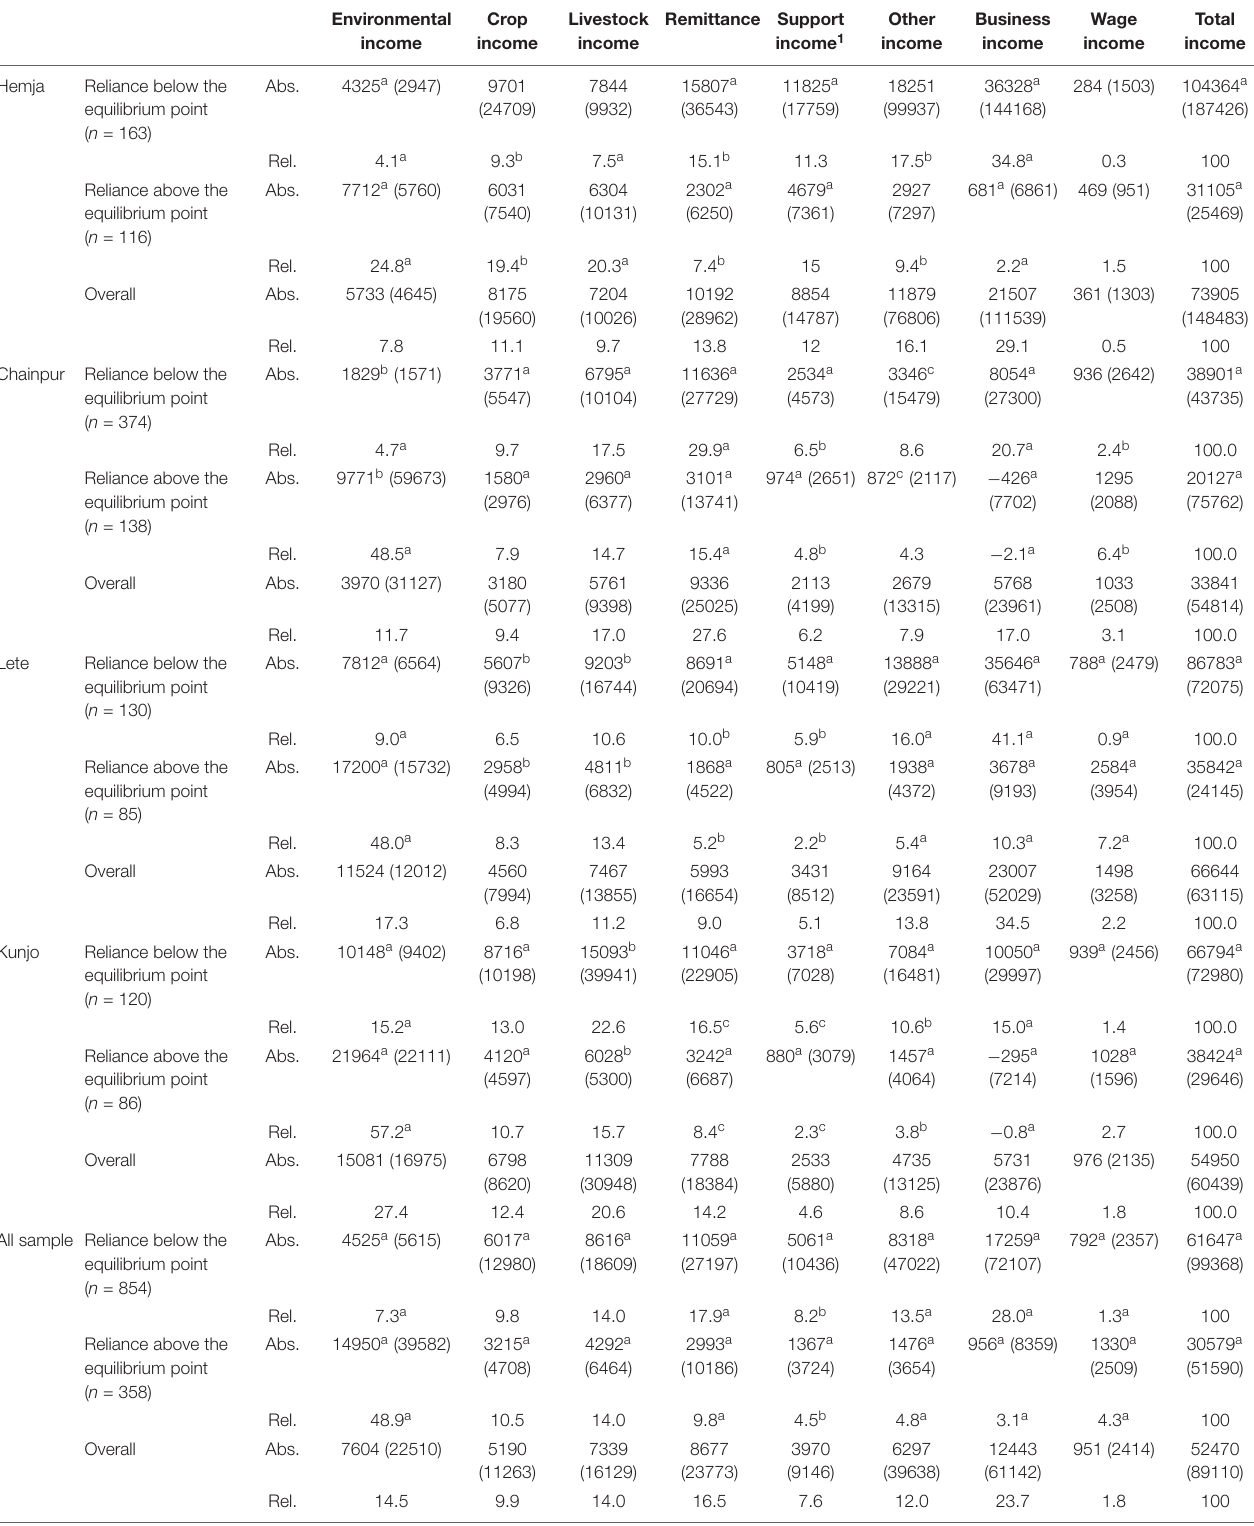
TABLE 2 | Household absolute (Nr/aeu in 2006 prices) and relative (%) mean income by source, site, and environmental reliance group, Nepal, 2006–2012; values in parenthesis are SD of the